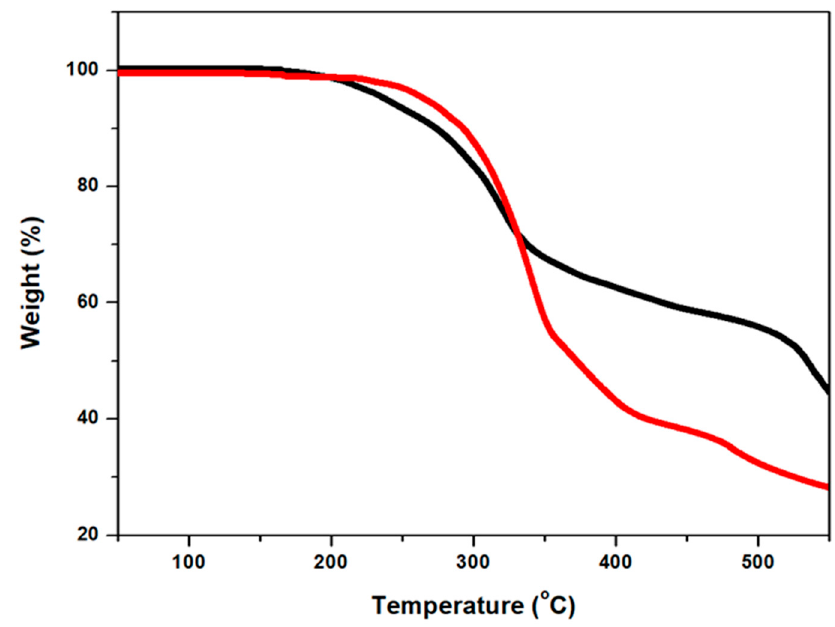
Figure 9. TGA curves of 1 (black) and 2